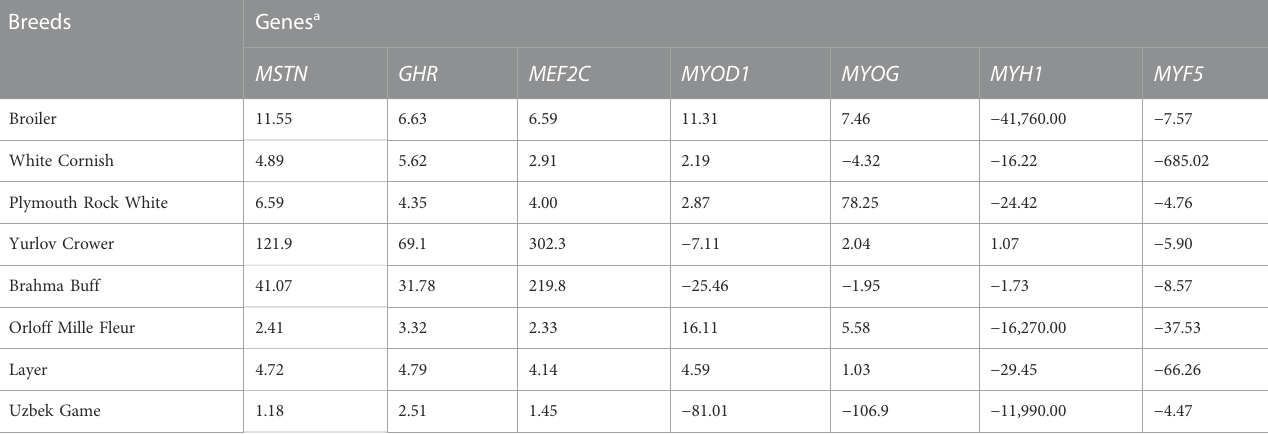
TABLE 3 Relative DGE levels de fi ned by raw FC values (type I data) in the thigh muscle tissues of E14 chick embryos as estimated in the studied breeds. Breeds Genes a MSTN GHR MEF2C